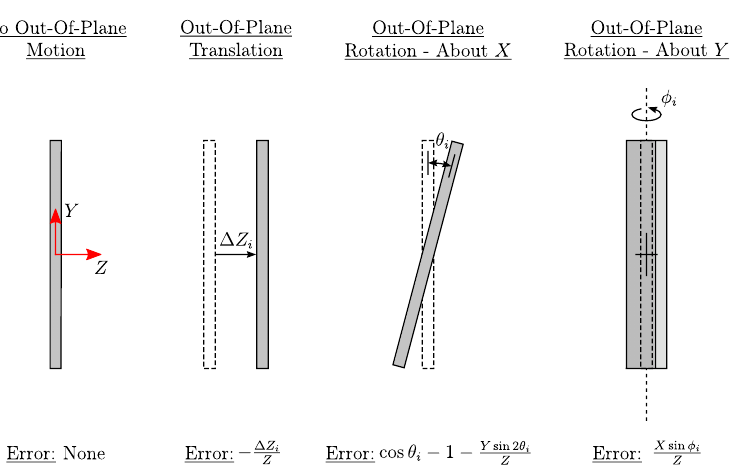
Figure 2. The possible forms of out-of-plane motion which can occur during a test and the corre- sponding equations which describe their strain